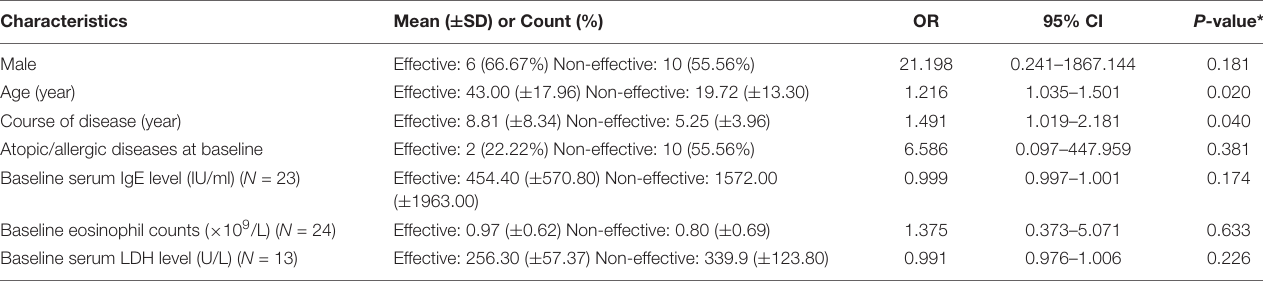
TABLE 2 | The relationship between clinical characteristics and efficacy at 4 weeks (EASI improvement of more than 50% at 4 weeks is defined as effective, of which 33.33% is effective) ( N = 27). Characteristics